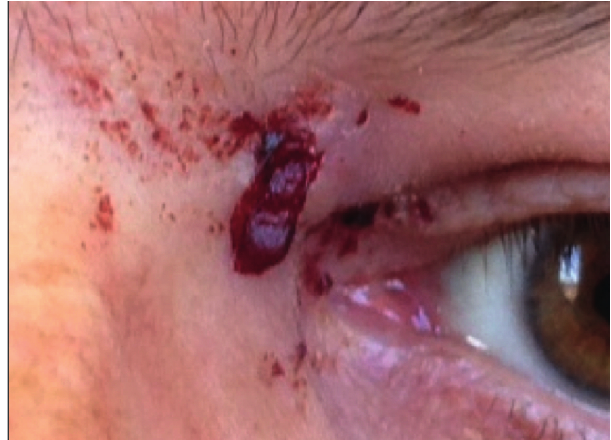
Figure 2. Bloody secretion from a sinocutaneous fistula (at first visit) is